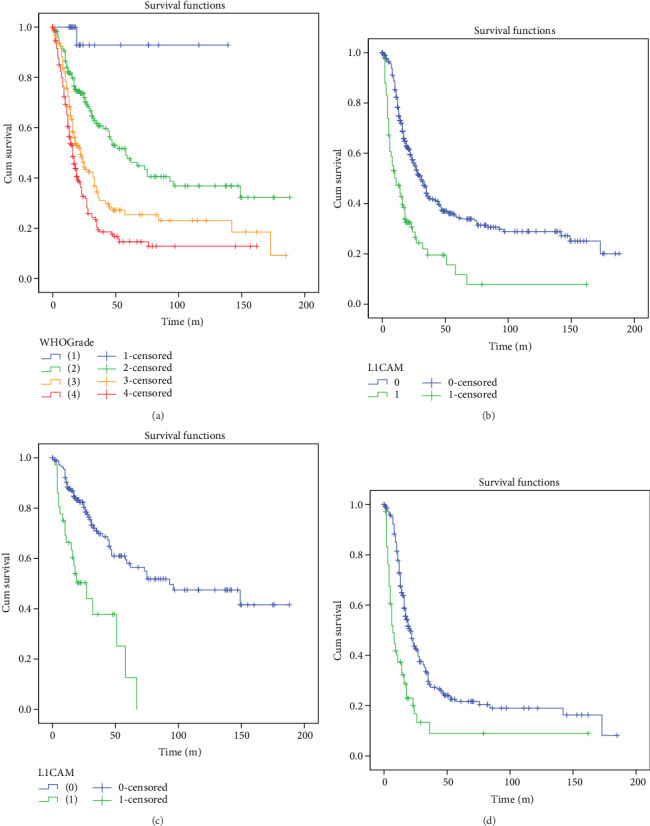
High L1CAM expression was associated with significantly shorter OS both in high-grade and low-grade gliomas (a) The OS of all glioma patients in our cohorts grouped by WHO grade. (b) The OS of L1CAM in all glioma patients. (c) The OS of L1CAM in low-grade glioma patients (WHO I and II). (d) The OS of L1CAM in high-grade glioma patients (WHO III and IV).